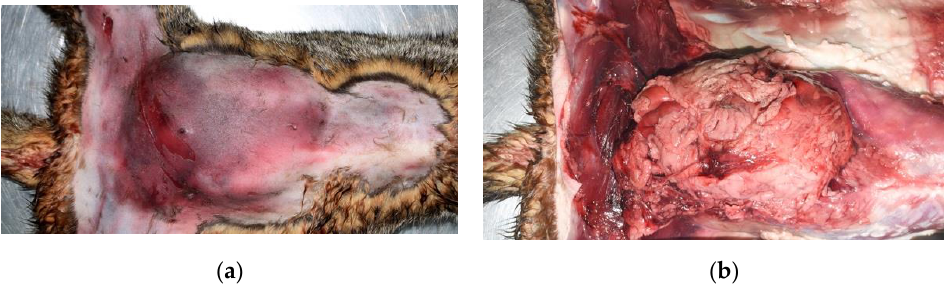
Figure 3. The “iceberg” feature of a dog bite injury to the abdomen of a cat. ( a ) After hair shaving, only swelling and massive contusion on the skin of the abdomen is noted. ( b ) After skin reflection, the abdominal cavity and subcutis herniation of the intestine and omentum from the lacerated abdominal wall can be identified.